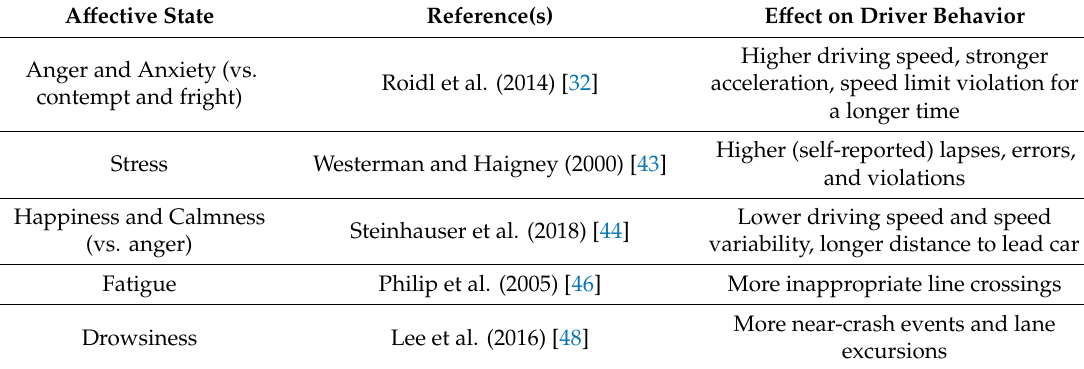
Table 1. Representative studies on the relationship between a ff ect detection and driver behavior. A ff ective State Reference(s) E ff ect on Driver Behavior Higher driving speed, Anger and Anxiety (vs. Roidl et al. (2014) [32] contempt and fright)